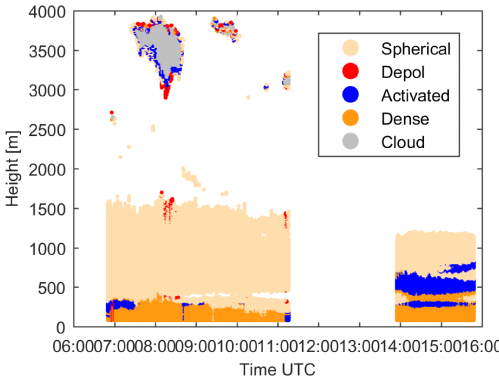
Figure 6. Four different aerosol classes (spherical particles – light yellow, depolarization particles – red, activated particles – blue, and dense particles – dark yellow) and cloud (gray) on 10 June 2020 based on the lidar classification method.